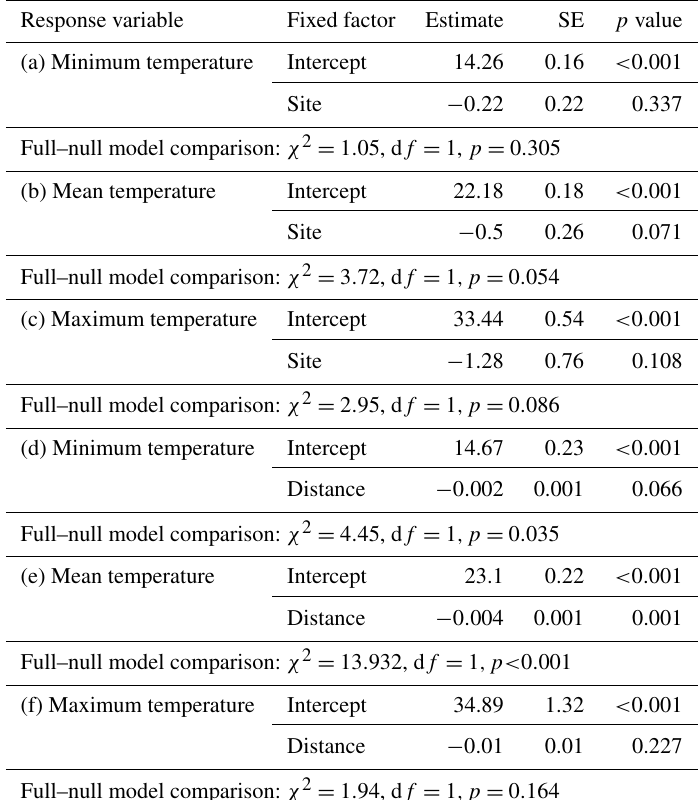
Table 2. Parameter estimates from the linear mixed model (LMM) fitting differences in minimum, mean, and maximum temperature between study sites (a–c) and as a function of the distance to the edge border (d–f) with corresponding full–null model